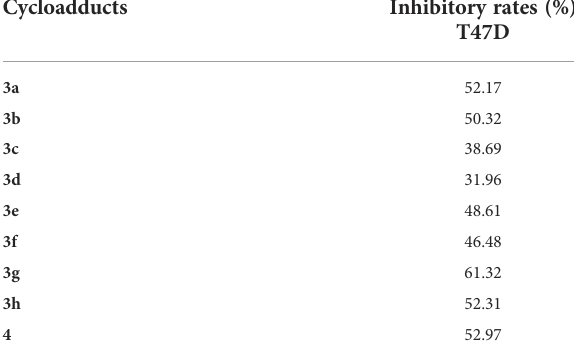
TABLE 2 The inhibitory rates of the target compounds on breast cancer cells (100 m mol/L). Cycloadducts Inhibitory rates